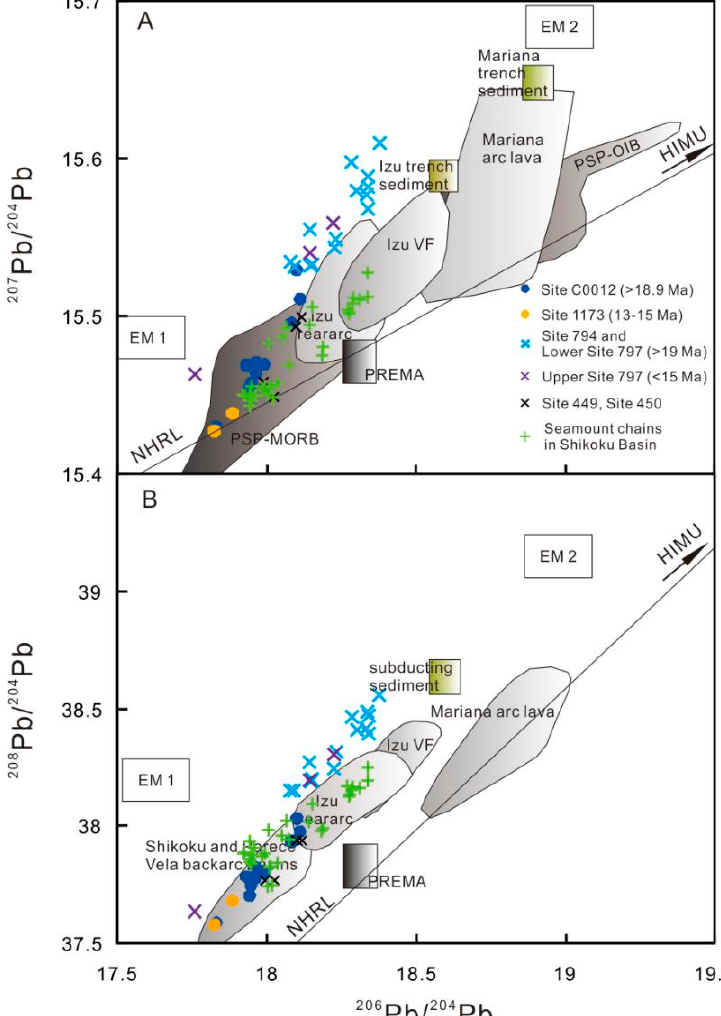
Figure 11. 207 Pb/ 204 Pb vs 206 Pb/ 204 Pb ( A ) and 208 Pb/ 204 Pb vs 206 Pb/ 204 Pb ( B ) plots for Cenozoic volcanic rocks of the Site C0012 and Site 1173 in the Shikoku Basin. Data sources as for Figure 10. The fields of Izu-Bonin arc lava and Mariana arc lava are cited from Reference [57]; the fields of Philippine Sea Plate-mid-ocean ridge basalts (PSP-MORB), PSP-ocean island basalts (OIB), Shikoku and Parece Vela back-arc basins, Izu rear-arc, Izu volcanic front (Izu VF) are cited from Reference [62]; the fields of enriched mantle 1 (EM1), EM2, PREMA are cited from Reference [56]; the Northern Hemisphere Reference Line is cited from Reference [63].